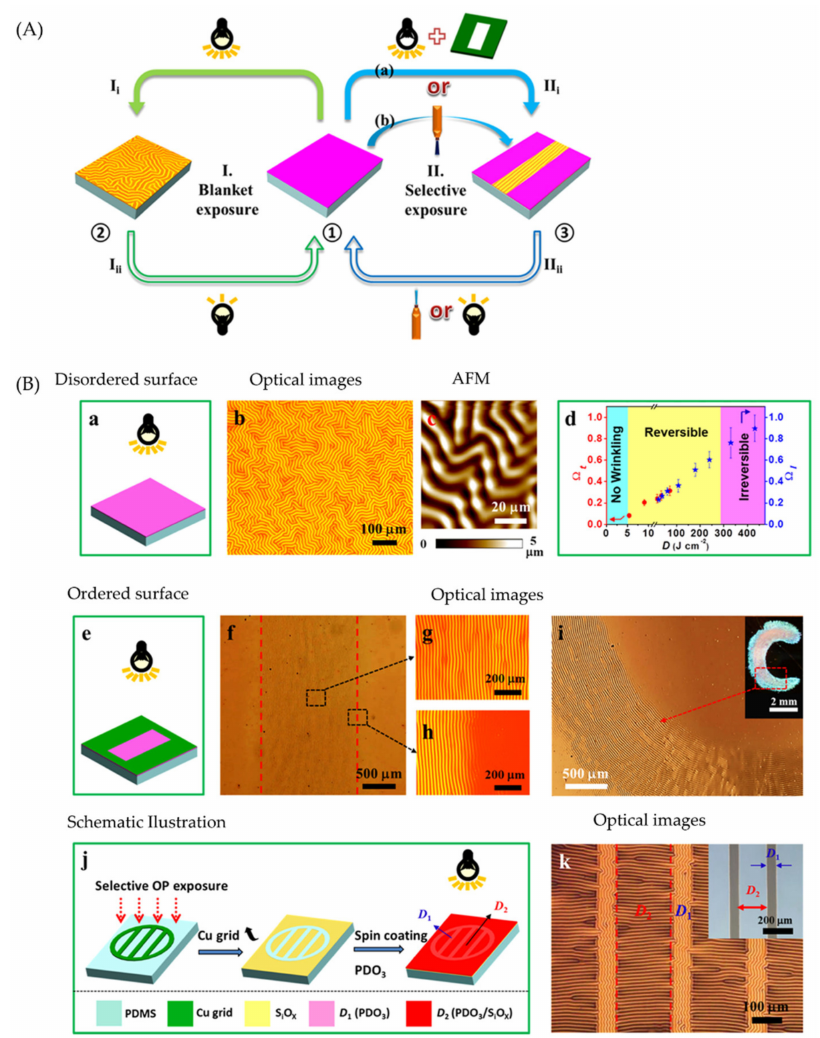
Figure 4. ( A ) Schematic illustration of the all-optical reversible surface patterning strategy and ( B ) Disordered/ordered surface wrinkling induced by the controlled exposure of the PDO3/PDMS bilayer to a high-intensity white light. Schematic illustration (a), optical (b), and atomic force microscopy (AFM) height (c) images of labyrinth wrinkles induced by blanket exposure. (d) The dependence of the aspect ratio ( Ω t and Ω I ) of labyrinth wrinkles on the exposure dose D from different exposure times t and light intensity I employed, respectively. Schematic illustration (e) and optical images (f–i) of oriented wrinkles resulting from selective exposure through an oblong-shaped mask with the width of 1.5 mm and the length of 6 mm (f–h) or “C”-shaped mask with the hole width of 1 mm (i). Schematic illustration (j) and optical image (k) of dually oriented wrinkles induced by blanket exposure, where the substrate was pre-exposed to oxygen plasma through a copper grid (insert of (k)). Reproduced with permission from reference [43]. Copyright 2019, American Chemical Society